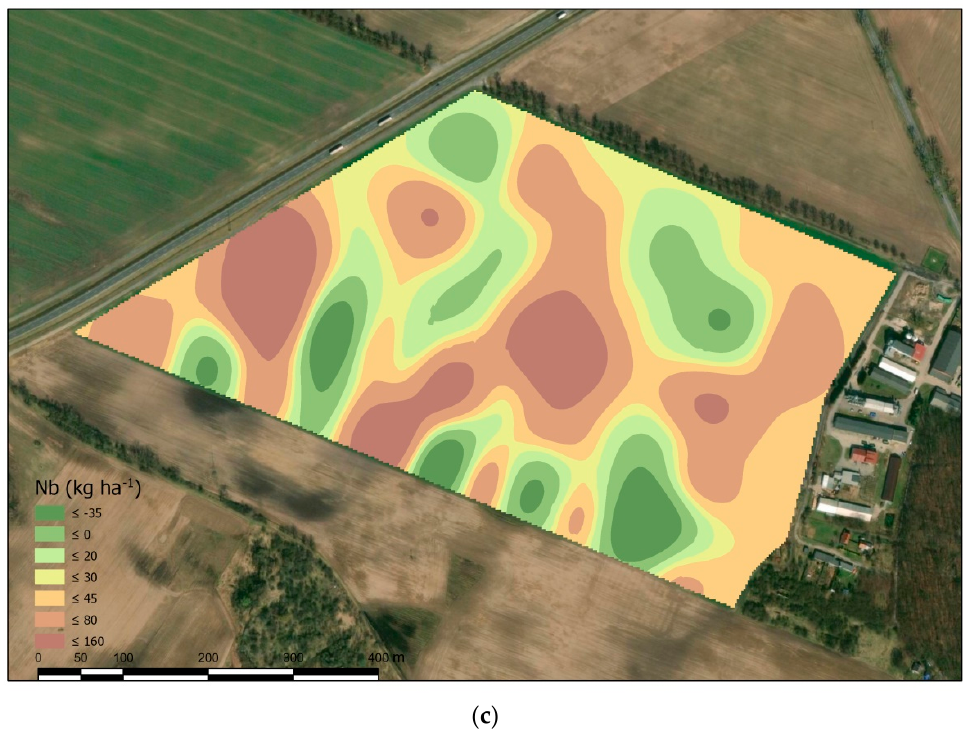
Figure 3. ( a ) Spatial distribution map of winter oilseed rape (cereals units) yield. ( b ) Spatial